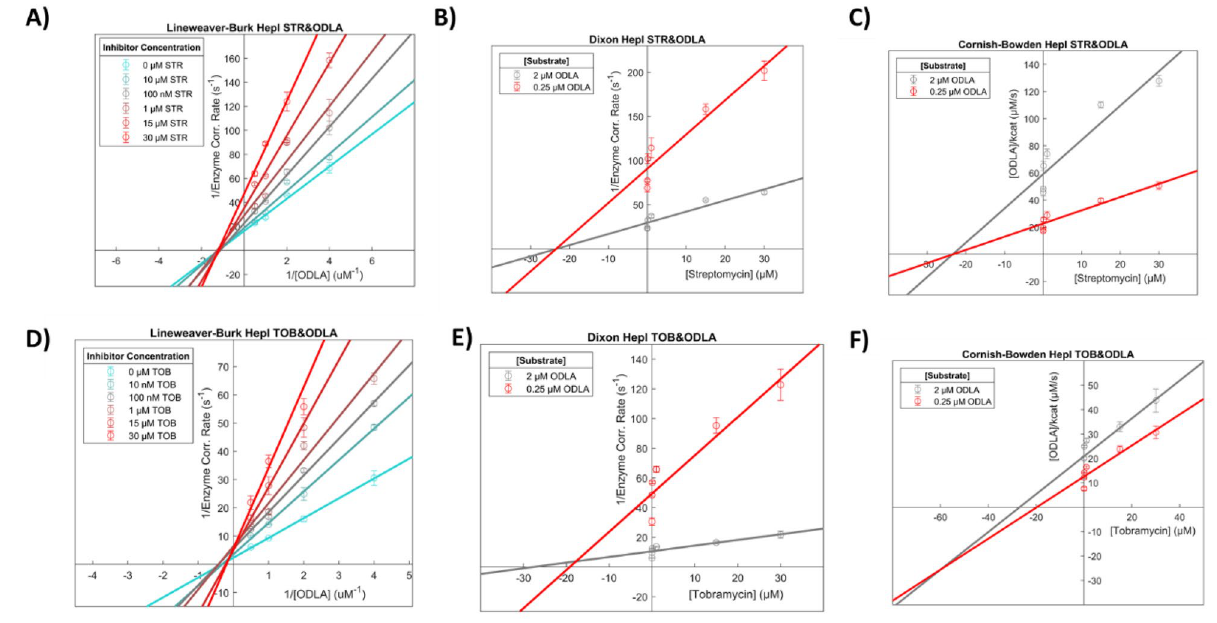
Figure 3. Kinetic analysis plots of ( A-C ) Streptomycin and ( D-F ) Tobramycin in the presence of Fig. 5E-F, Table 1). Specifically, mutation of the positively charged residues Arginine 60 and 120 to Alanine resulted in alterations of tobramycin inhibition of HepI (Table 1). The HepI R60A mutant exhibited a K i approxi- mately tenfold weaker relative to the WT, while the R120A demonstrated a K i ~ twofold tighter than the WT. Streptomycin exhibited non-competitive inhibition against both ODLA and ADPH, which was unambigu- ously evident with all three analysis methods (Fig. 3A-C, Supplemental Fig. 3D-F). Streptomycin binding to the enzyme was also investigated by way of K i analysis using mutant forms of HepI including: R60A, R61A, R63A, and K64A (Table 1, Supplemental Fig. 5A-D). Varying concentrations of Streptomycin with all four mutant forms increased the K